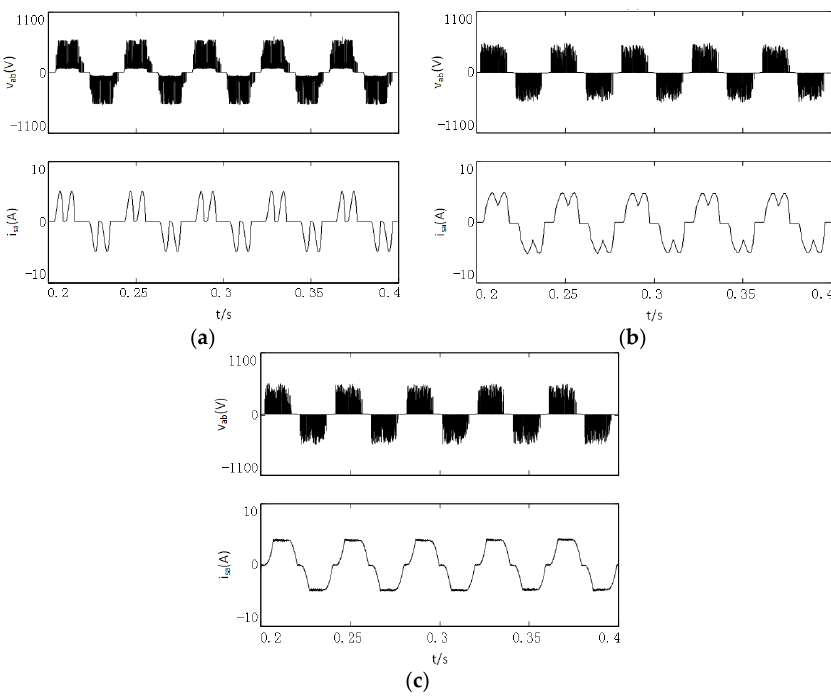
Figure 11. Simulation waveforms of the stator voltage and stator current of the PMSG with different impedance-source topologies. ( a ) With Z- source inverter; ( b ) With quasi-Z-source inverter; ( c ) With half quasi-Z-source inverter. Energies 2016 , 9 , 770